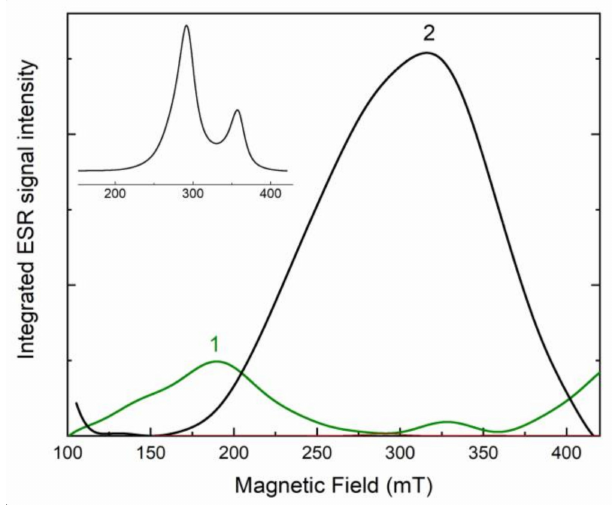
Figure 9. Electron spin resonance spectra of initial (green curve 1) and annealed (black curve 2) potassic-hastingsite. The ratio of curve 2 to curve 1 is given in the inset to the Figure.